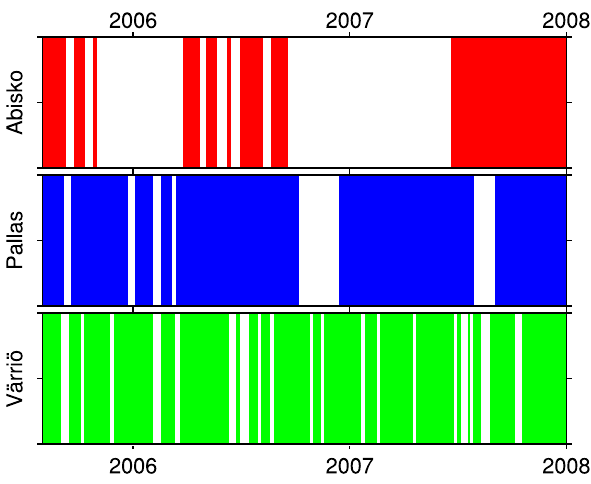
Fig. 2. Colored areas show the time intervals when particle number size distribution data is available from corresponding stations.